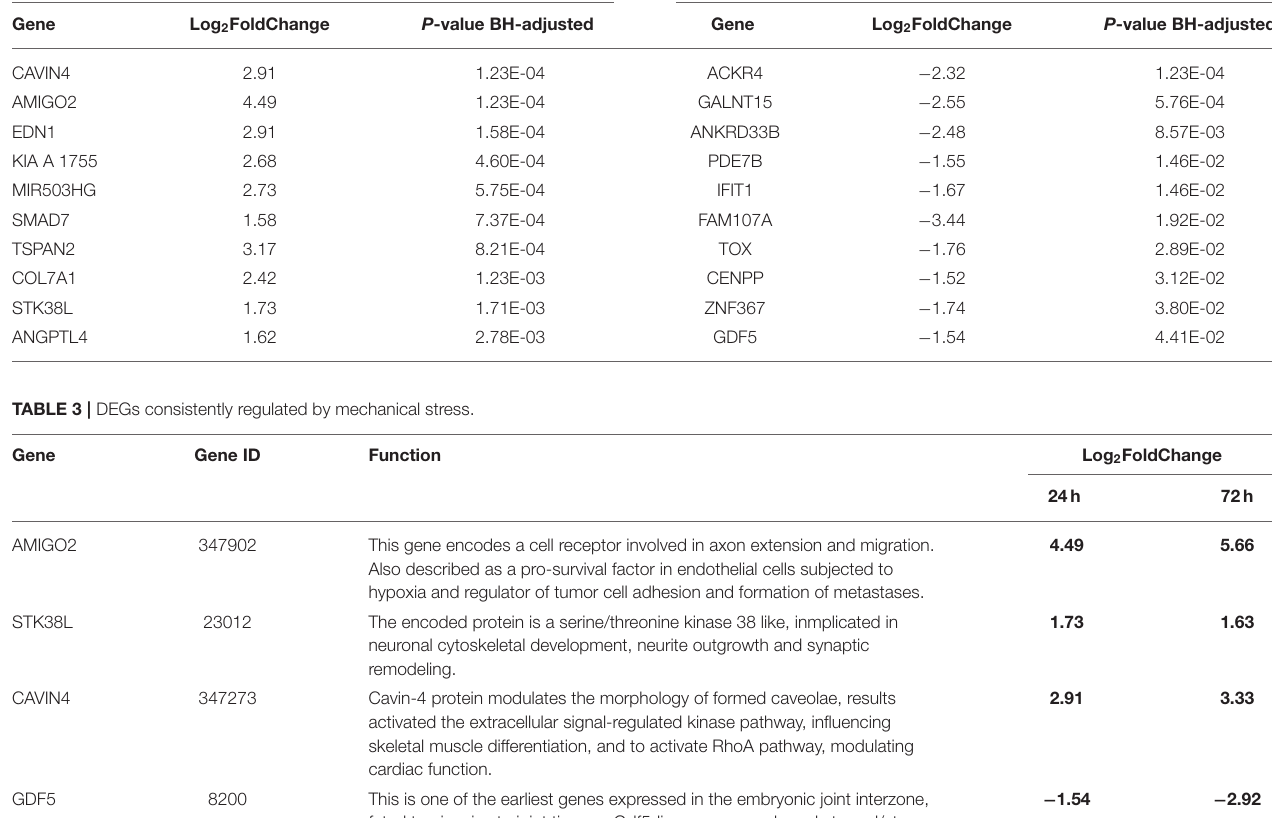
TABLE 2 | Top scored DEGs 24h dyn vs. 24h stat. Top10 up-regulated DEGs – 24h ON vs. 24h OFF Top10 down-regulated DEGs – 24h ON vs. 24h OFF Gene Log 2 FoldChange P -value BH-adjusted Gene Log 2 FoldChange P -value BH-adjusted CAVIN4 2.91